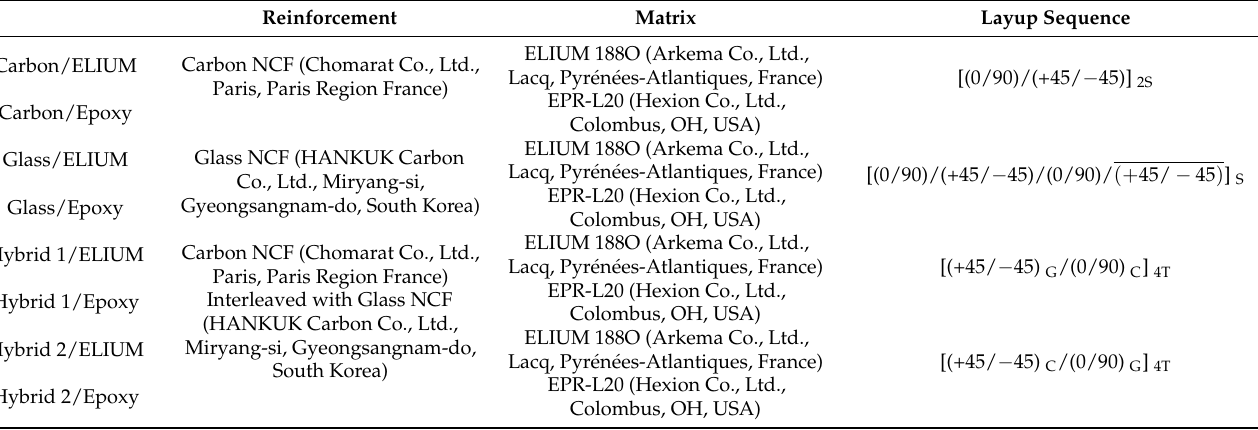
Table 1. Proposed analysis